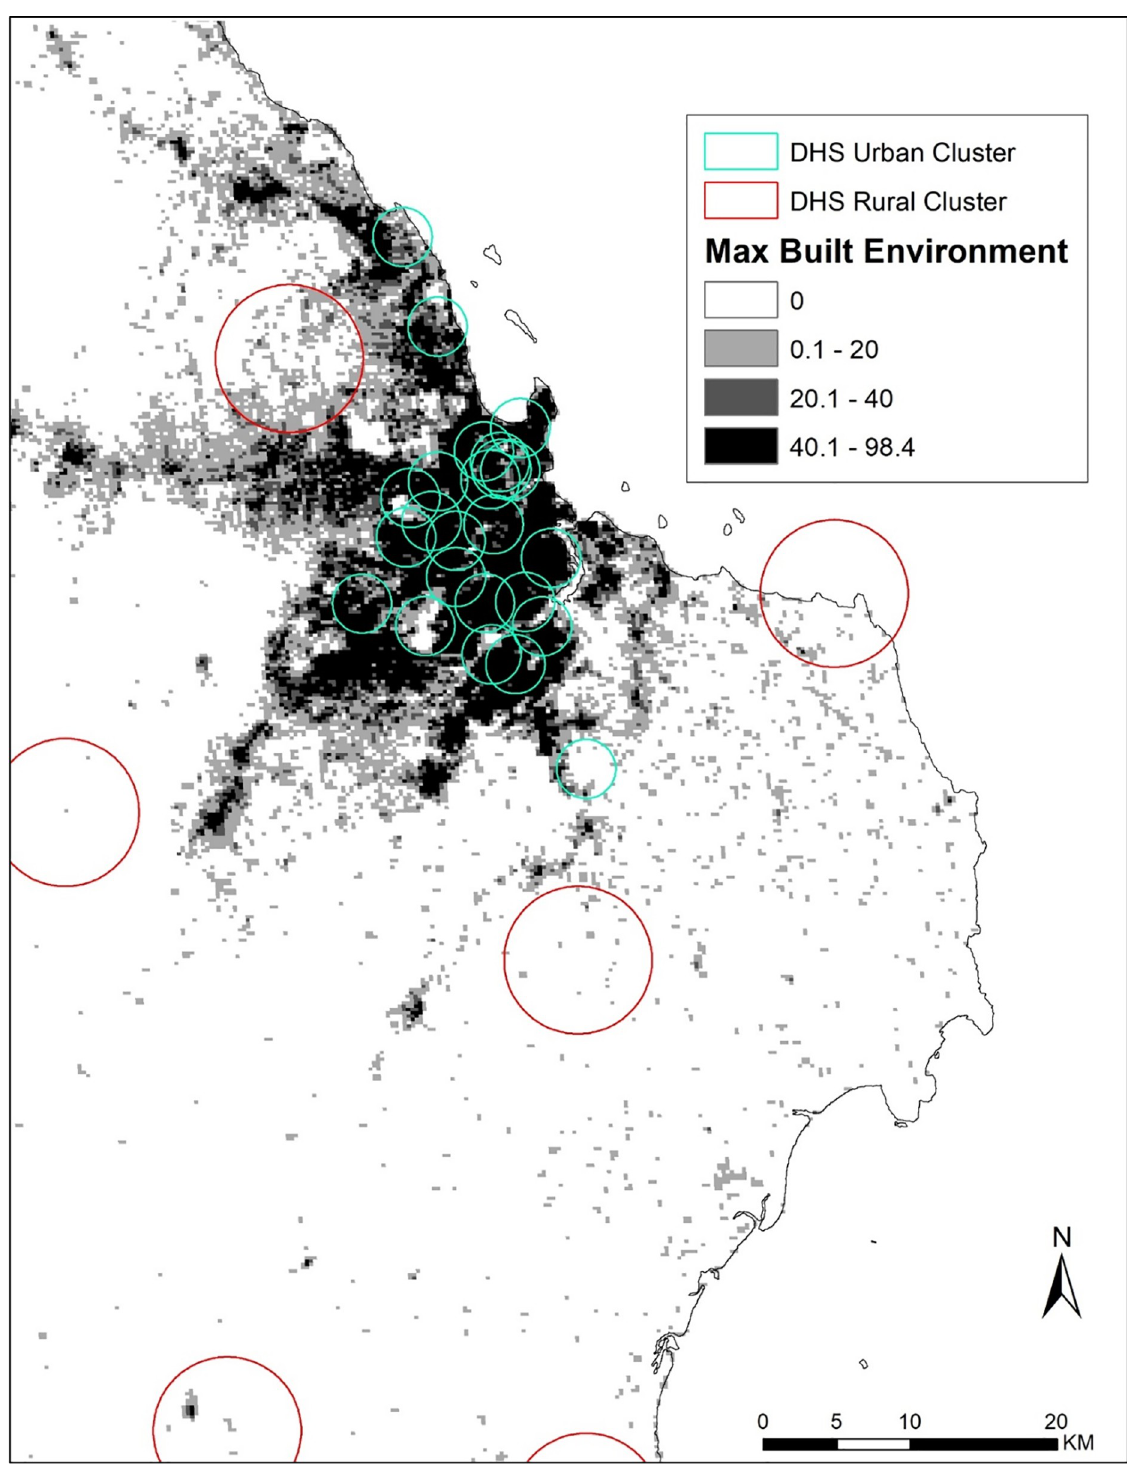
Fig 1. Spatial data layers, close-up of Dar es Salaam, Tanzania, Demographic and Health Survey 2010 and GHSL maximum built environment from 2014.